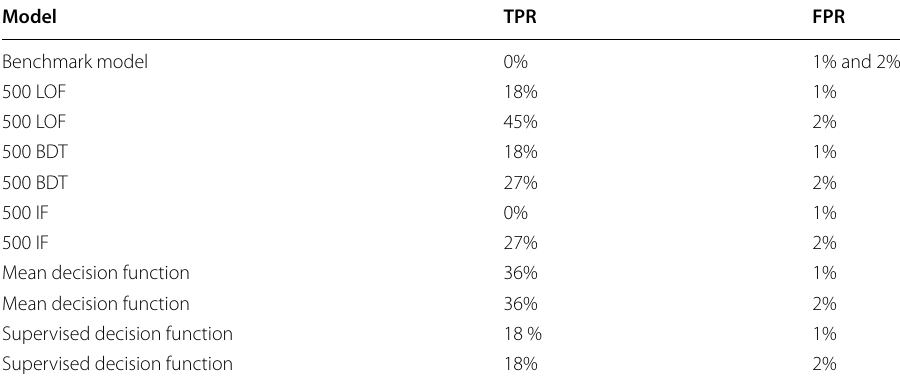
The results of the mean aggregation approach derived from an aggregation of three standalone ensembles consisting of 500 LOF, 500 BDT and 500 IF base learners, where aggregation was performed by taking the mean value of decision functions from three different types of base learners